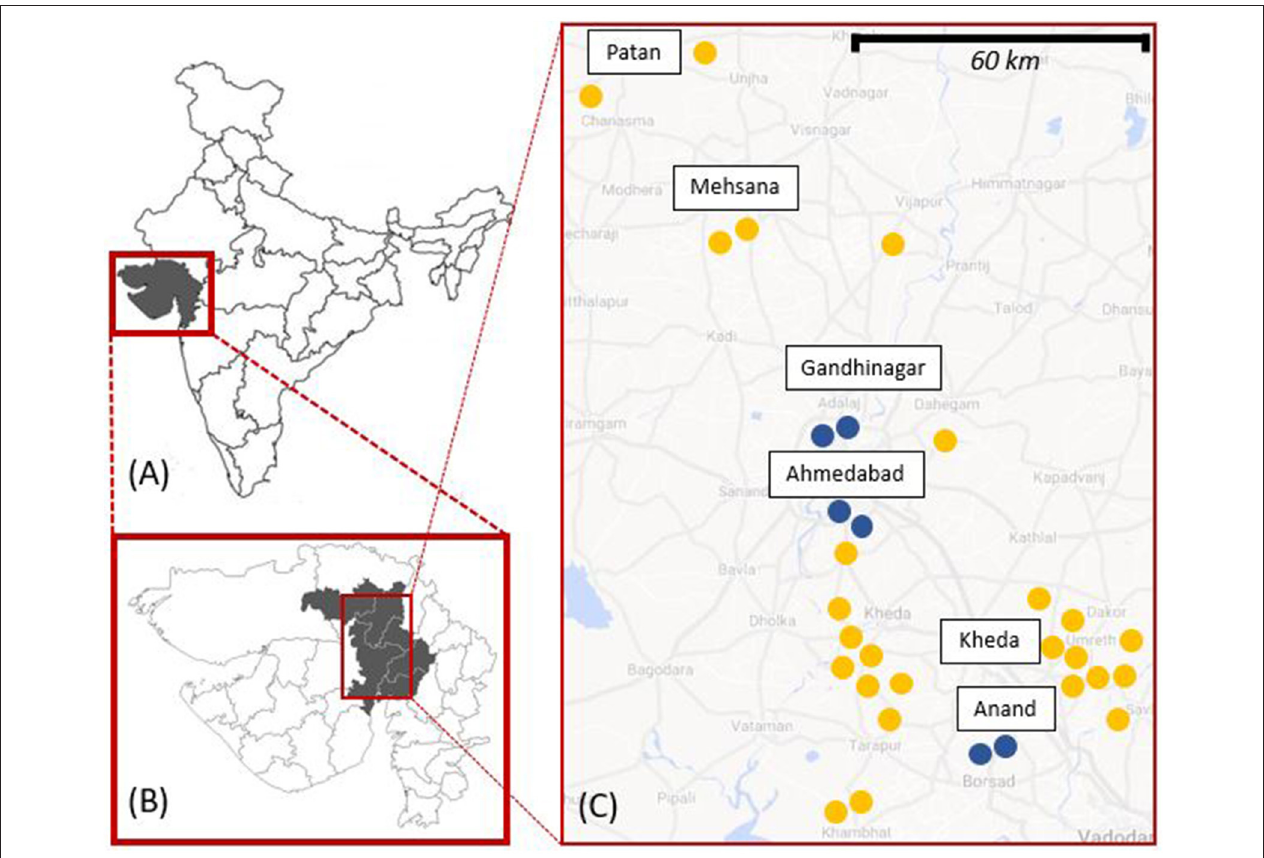
FIGURE 1 | Map showing: (A) Gujarat; (B) the six districts of Patan, Mehsana, Gandhinagar, Ahmedabad, Kheda, and Anand; and (C) the approximate location of the 31 study sites (25 rural, in yellow, and 6 urban, in blue).